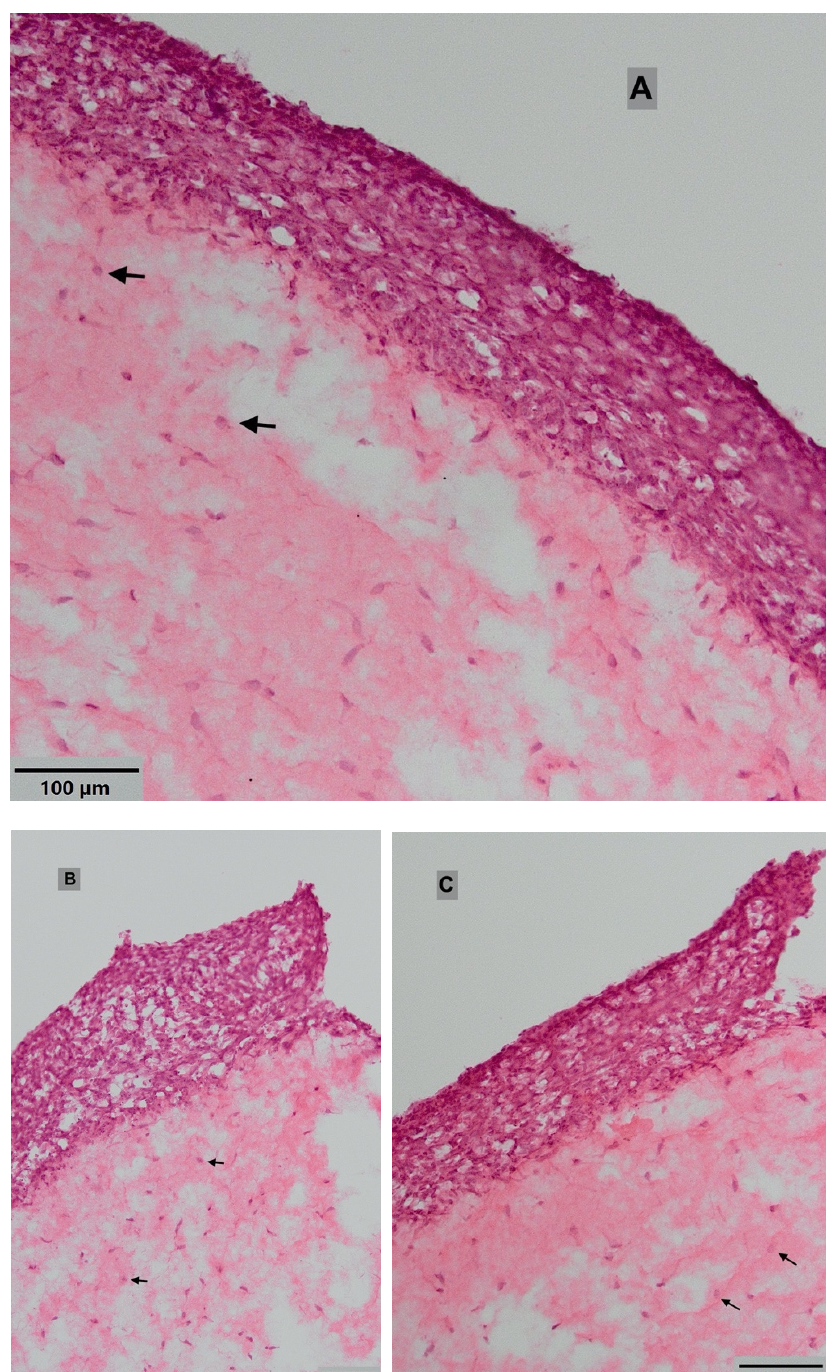
Figure 4. Histological views of oral mucosal models at ( A ) the center and ( B and C ) the edge of the oral mucosa at the biopsy interface. Black arrows show the monocytes in the connective tissue layer. Images were taken using light microscope at 10× magnification (haematoxylin and eosin (H&E) staining).